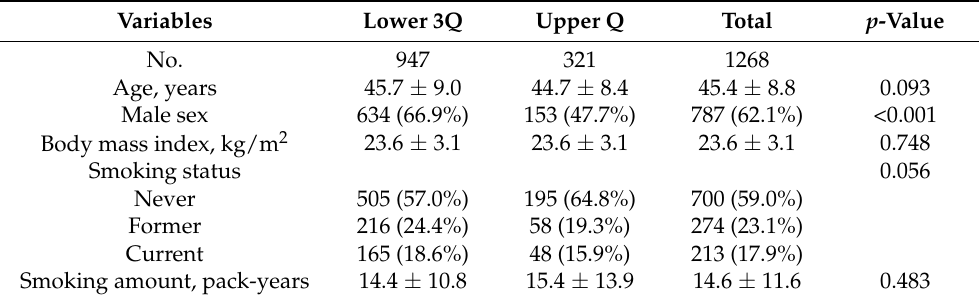
Table 1. Baseline demographics and laboratory findings between the upper and lower 3 quartiles